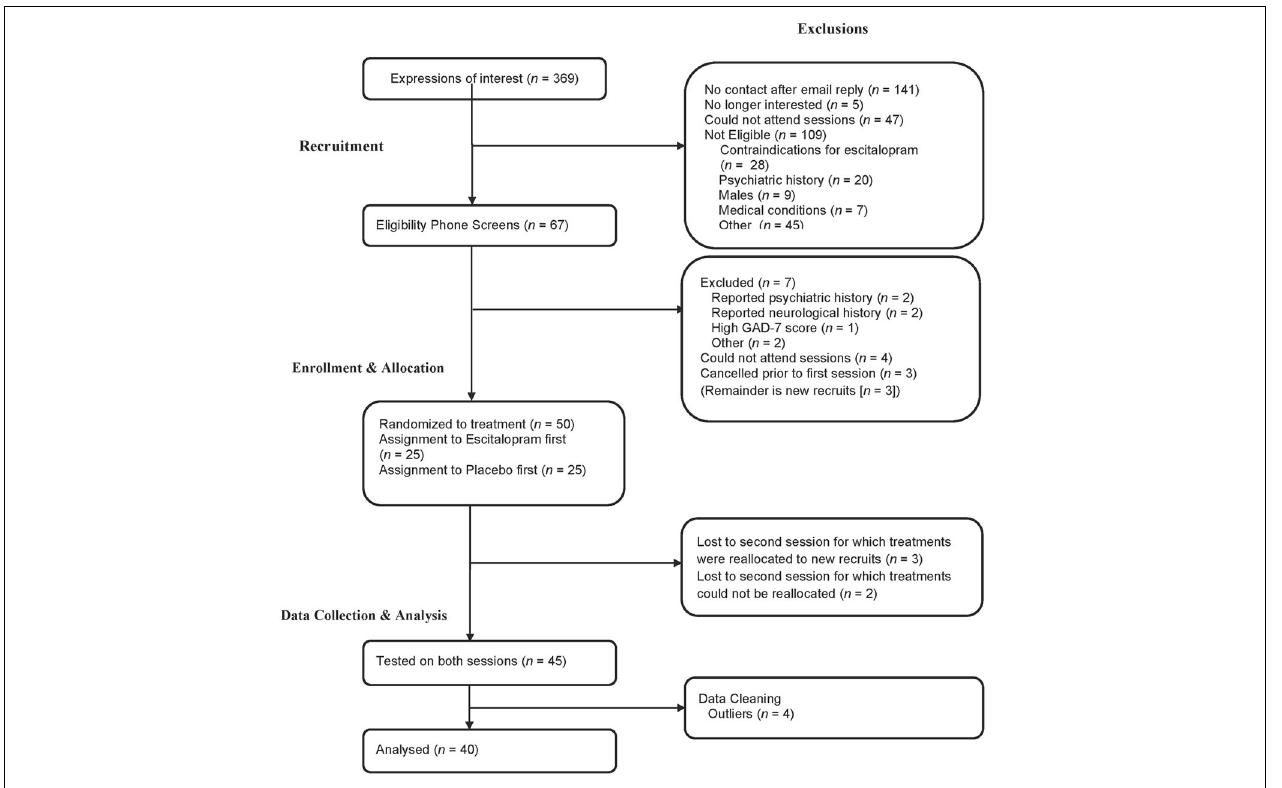
FIGURE 1 | A depiction of participants’ attrition from the experiment and the reasons and stages at which they were